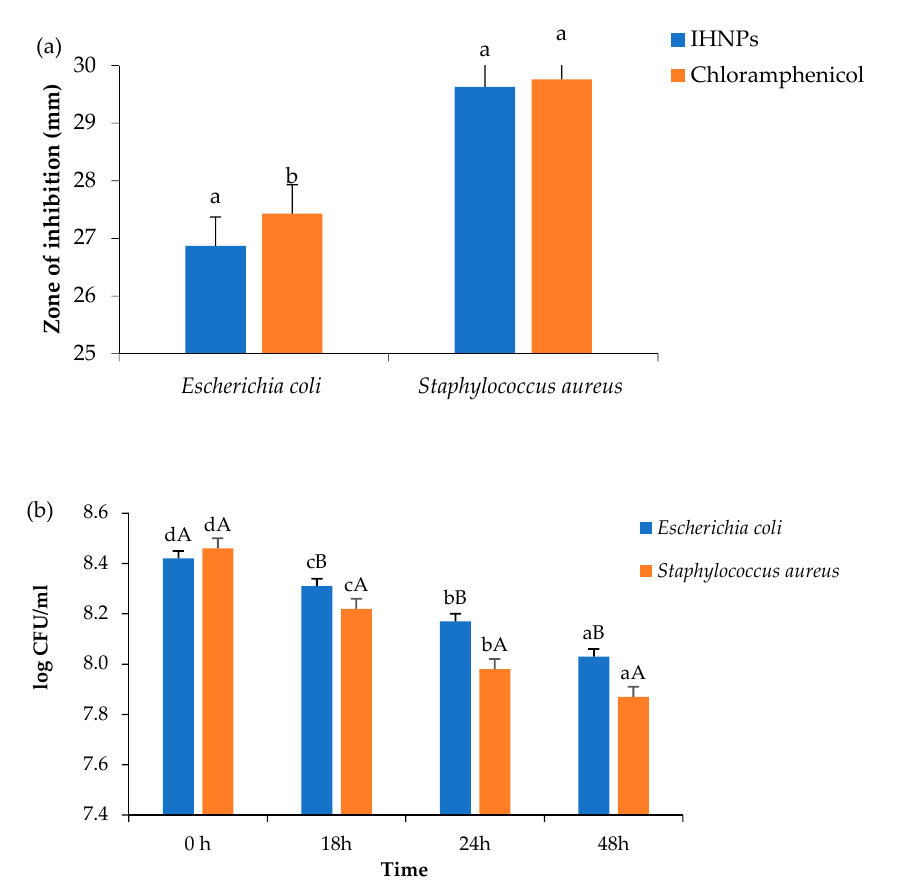
Figure 4. ( a ): Zone of inhibition; ( b ): Time kill study of gum arabic stabilized IHNP’s against pathogenic microorganisms. Data are presented as means ± SEM (n = 3). a,b Means within the row with different lowercase superscript are significantly different ( p < 0.05) from each other; A,B Means within the row with different uppercase superscript are significantly different ( p < 0.05) from each other.